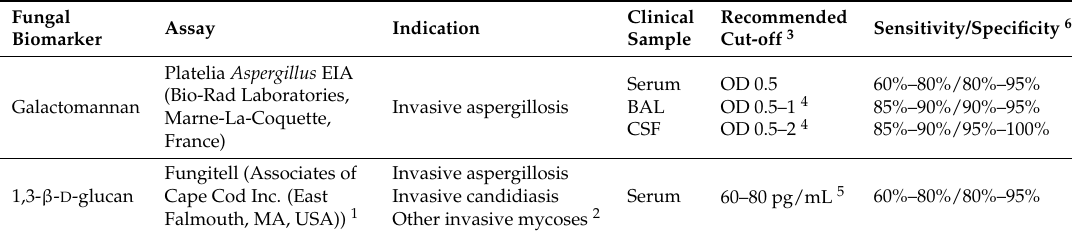
Table 1. Characteristics of the galactomannan and 1,3- β - D -glucan